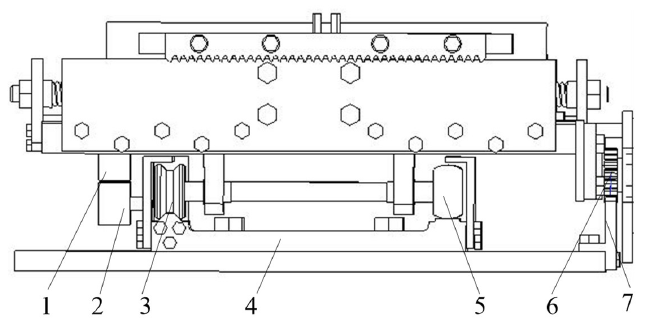
Figure 5. Structure of the double-deck sliding platform. 1. Indicative grating, 2. Scale grating, 3. V-type wheel, 4. Slide rail seat, 5. Roller, 6. Rack, 7. Pinion.